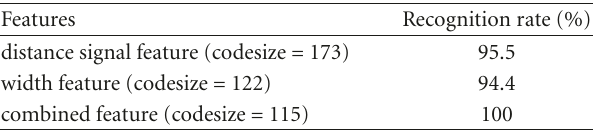
Table 5: The classification times of Bayes rule.